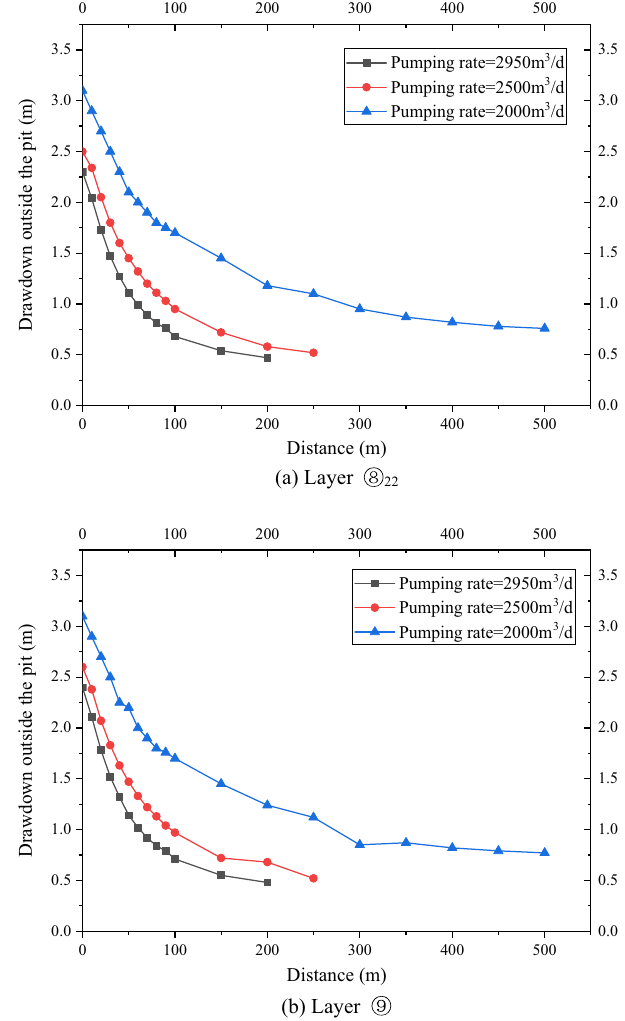
Figure 10. Drawdown–distance curve outside the pit with different pumping rates.